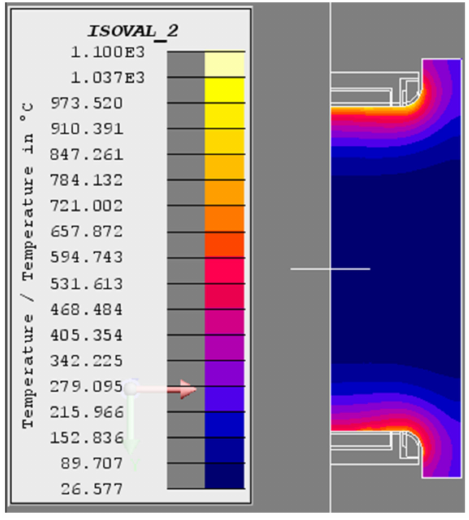
Figure 7. Temperature field of the crankshaft (T = 12 s).